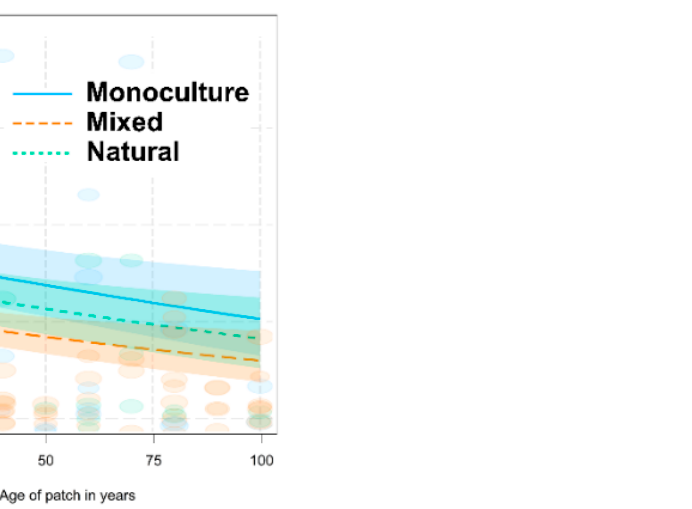
Figure 5. The proportion of felled basal area in a patch in relation to the age of the patch for individual types of forests (estimate ± 95% CI). The size of the ellipses reflects the number of woody plants in the patch.